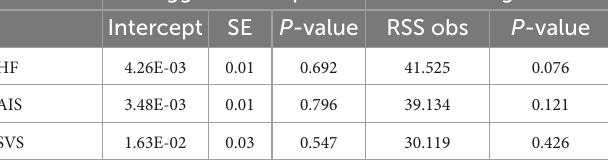
TABLE 3 Results of horizontal pleiotropy by MR-Egger intercept test and MR-PRESSO global test. Outcome MR-egger intercept test MR-PRESSO global test Intercept SE